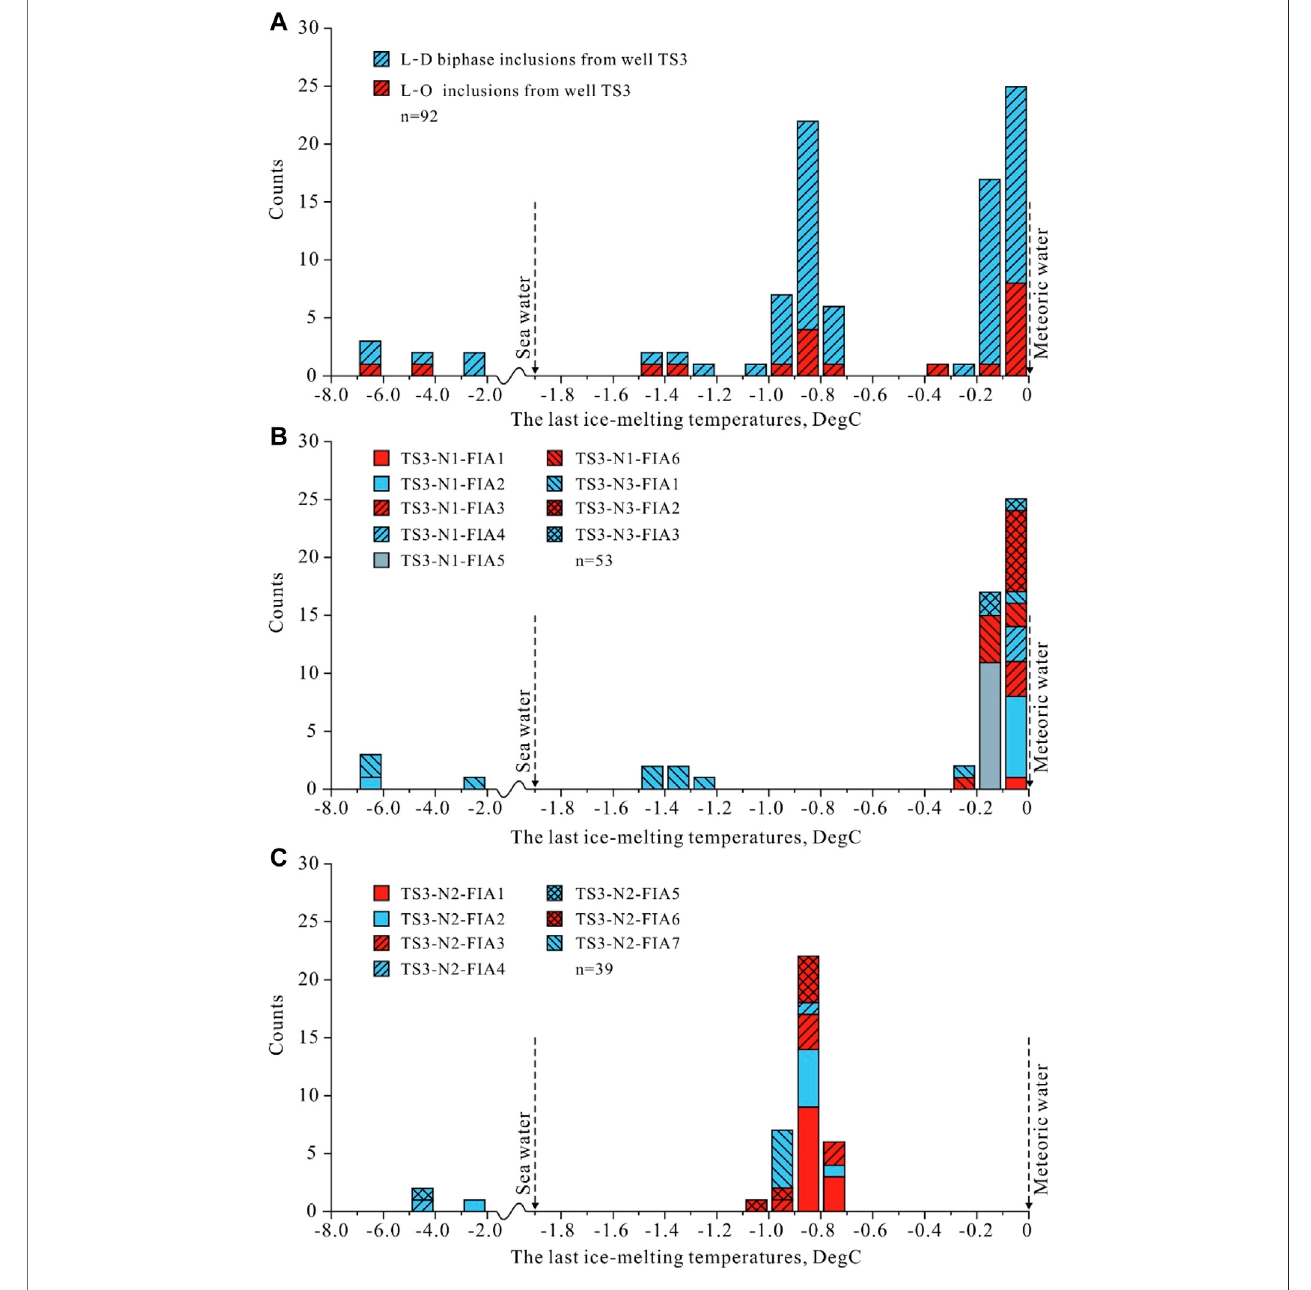
FIGURE 7 | (A) Histograms of ice-melting temperatures of fl uid inclusions in TS3. (B) Histograms of T m-ice with the highest T m-ice of 0 ° C in individual FIA. (C) Histograms of T m-ice with the highest T m-ice of − 0.7 ° C in individual FIA. The petrographic evidence that supports the FIAs can be found in Figure 5 ; Table 1 .